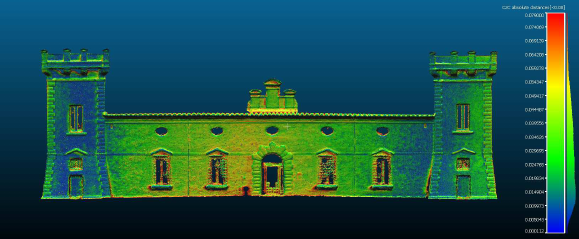
Figure 12: Comparison between photogrammetric point clouds and TLS one. Comparison made by CloudCompare (dataset 02)